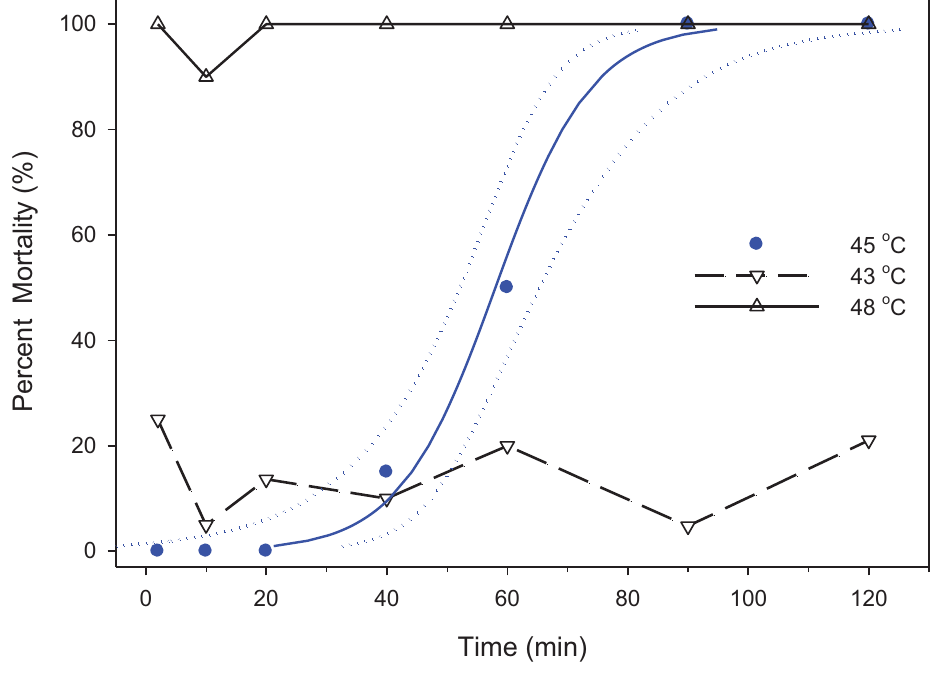
Figure 2. Threshold temperature for mortality of adult bed bugs ( (cid:2) ; Logistic regression ── , CL (cid:3)(cid:3)(cid:3)(cid:3) ) within 2 h of attaining a target temperature of 45 °C. The other two lines indicate mortality of bed bugs above and below this threshold temperature. Regression